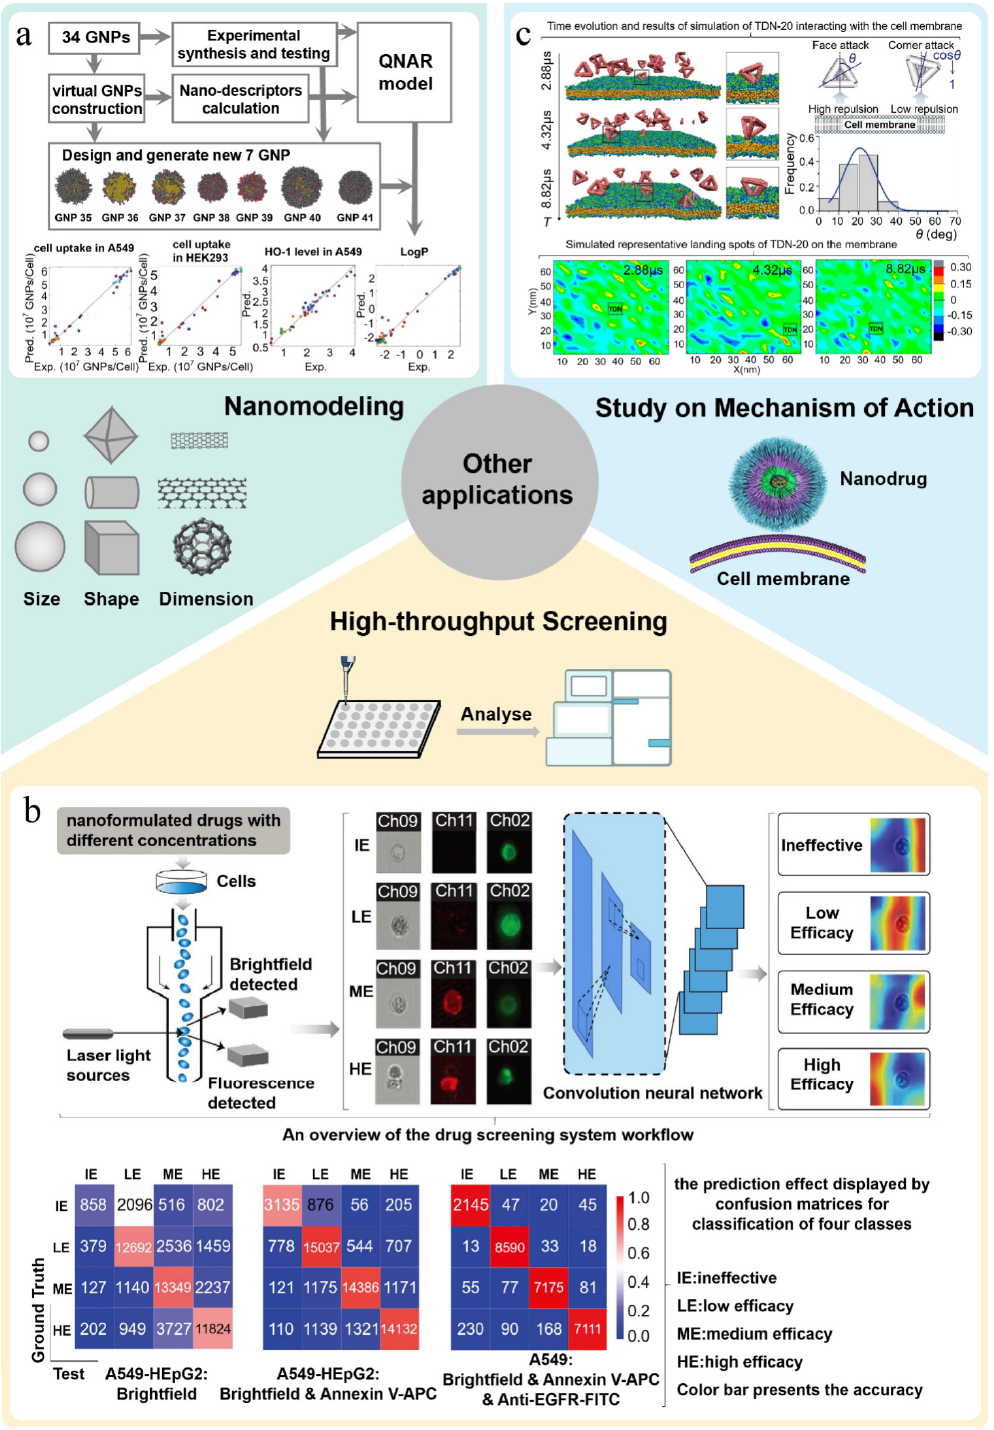
Figure 6. Computational applications in other aspects of nanodrug development. ( a ) Schematic workflow of predictive modeling and QNAR model performance. Adapted with permission from [24], American Chemical Society, 2017. ( b ) A drug screening system utilizing convolutional neural network based on flow cytometry single-cell images provides accurate and rapid approach for screening drug and nano-carrier drug system. Adapted with permission from [113], Wiley Online Library,